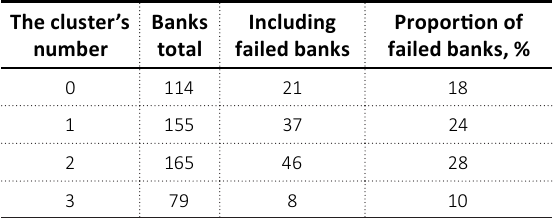
Table 3. Statistical characteristics of parameter 15 after eliminating anomalous values Column